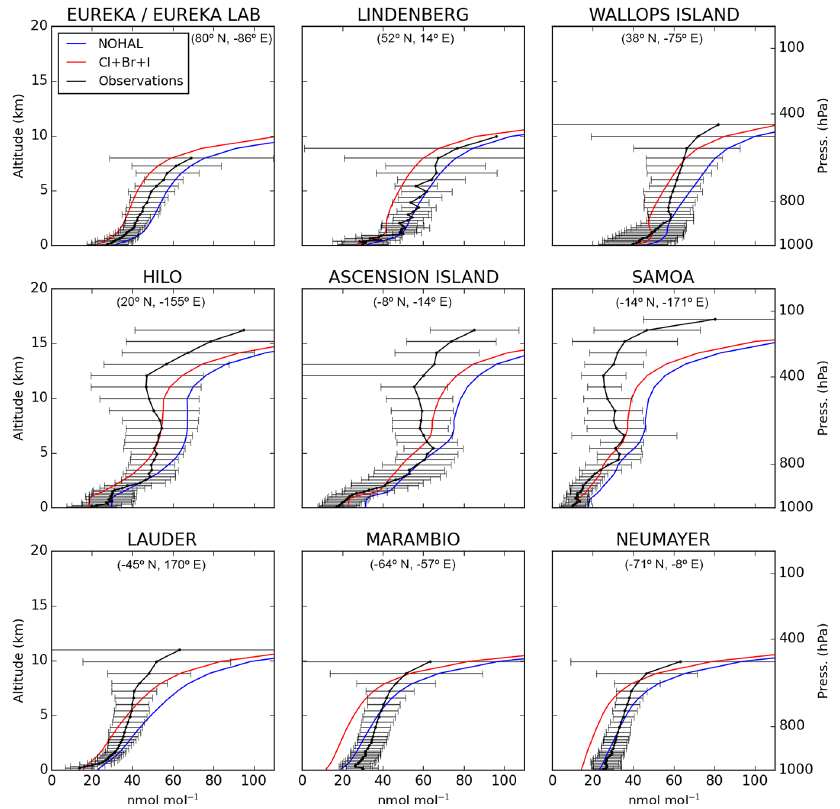
Figure 14. Comparison between annual modelled O 3 profiles and sonde data (2005). Profiles shown are the annual mean of available observations from World Ozone and Ultraviolet Radiation Data Centre (WOUDC, 2014) and model data for 2005 at given locations. Blue and red lines represent simulations without halogens (“NOHAL”) with halogens (“Cl + Br + I”), respectively. Observations (in black) show mean concentrations with upper and lower quartiles given by whiskers. Locations of observations are shown in Fig. 21.